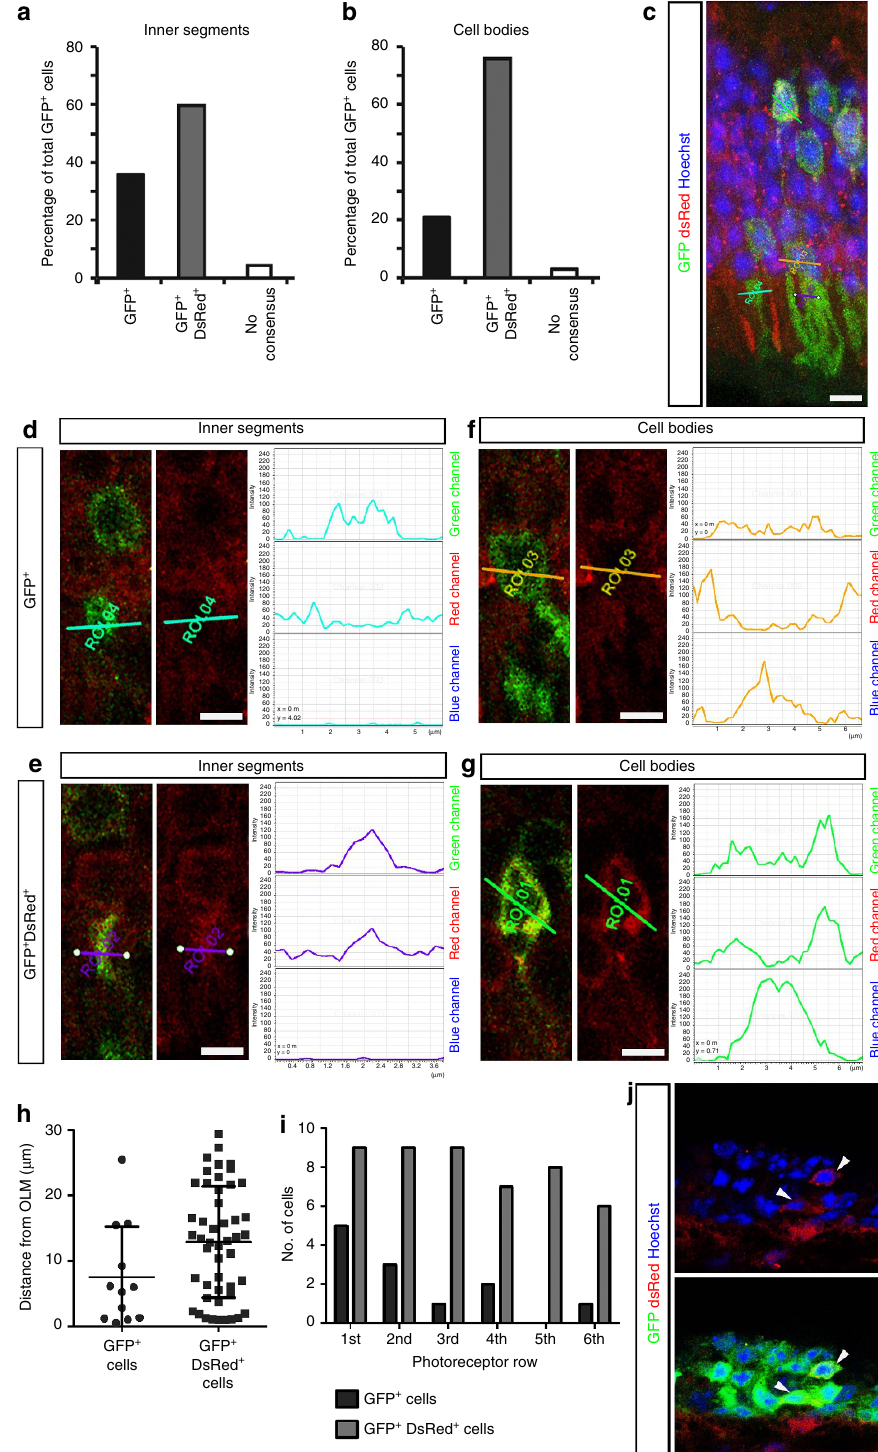
Figure 2 | Host and donor photoreceptor exchange fluorescent reporter proteins as assessed by confocal imaging. NrlGFP post-mitotic photoreceptor precursor donor cells ( green ) were transplanted into DsRed ( red ) hosts and examined by confocal microscopy 5-6 weeks post transplantation. Nuclei are labelled with Hoechst ( blue ). ( a , b ), histograms showing quantification of the proportion of cells analysed ( n ¼ 157 cells; N ¼ 5 retinae) that expressed GFP alone (GFP þ ) or GFP and DsRed (GFP þ /DsRed þ ) when measuring inner segments ( a ) or cell bodies ( b ). ( c ), confocal projection image of a representative host retina. Lines represent regions of interest (ROIs) through cells and inner segments shown in ( d – g ). ( d ), ( e ) single confocal sections and the respective line plots through two inner segments and ( f , g ), two cell bodies shown in ( c ). ( h , i ), scatter plot (mean ± s.d.) and histogram showing the position of GFP þ and GFP þ /DsRed þ photoreceptors with respect to the outer limiting membrane (OLM) of host retina. The relative positions of the two populations were significantly different ( P ¼ 0.0486 two tailed t-test with Welch’s correction; P o 0.001 2-way ANOVA). ( j ), confocal projection image showing donor NrlGFP þ cells in SRS of DsRed þ host. Arrows , donor GFP þ cells that are DsRed þ . Scale bars 5 m m ( c ), 3 m m ( d ) and 10 m m ( g ).